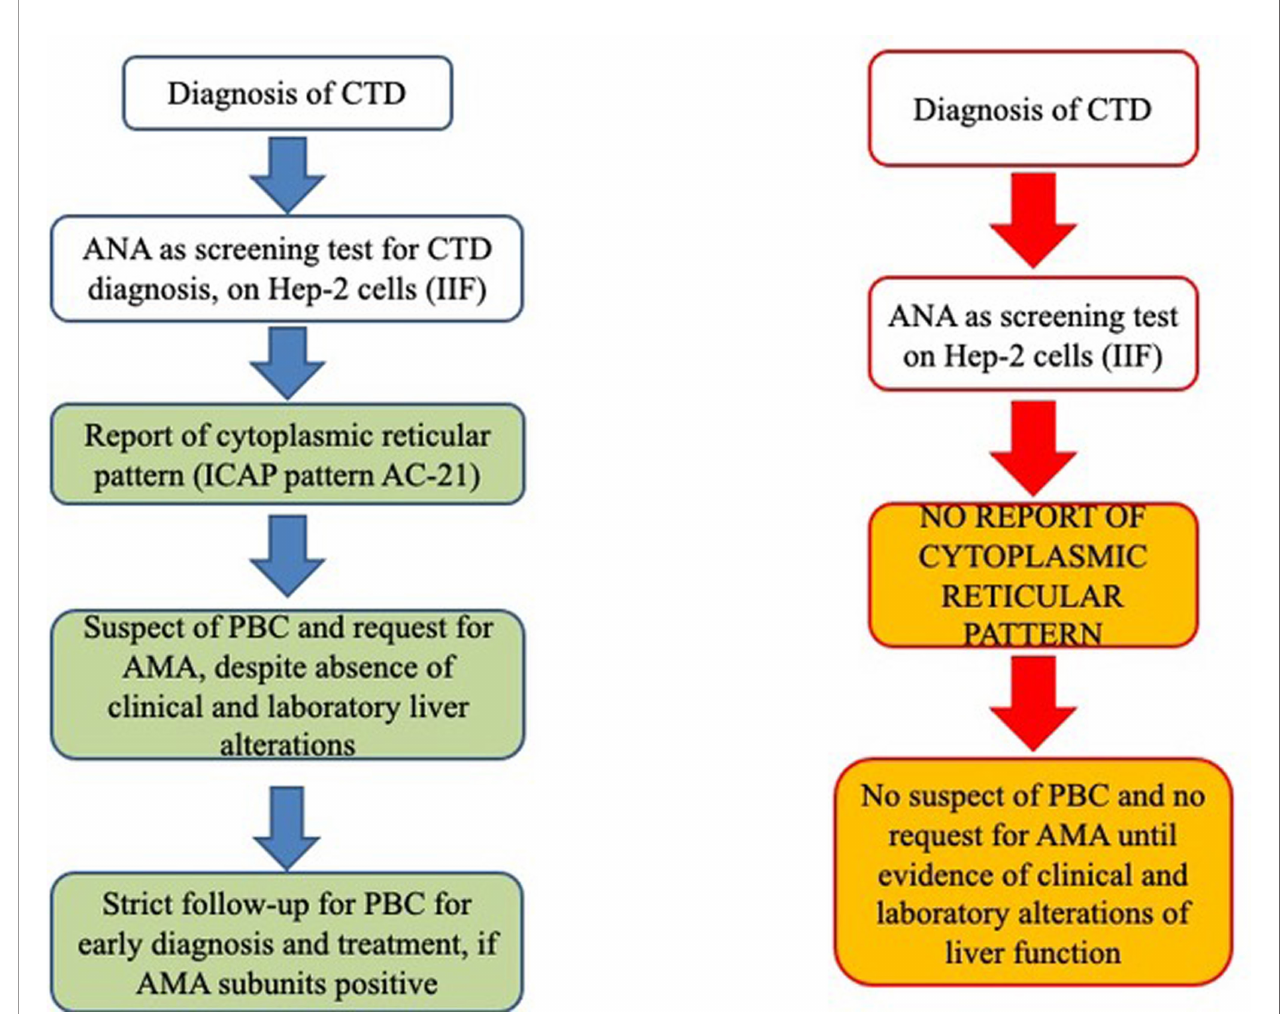
FIGURE 4 | Schematic representation of our proposed working model (left fl ow chart) from the report of cytoplasmic patterns at immuno fl uorescence to additional tests for AMA identi fi cation, before the onset of clinical features suggestive of altered liver function (right fl ow chart). AMA, antimitochondrial antibodies; ANA, antinuclear antibodies; CTD, connective tissue disease; ICAP, International Consensus on Antinuclear Antibody Patterns; IIF, indirect immuno fl uorescence; PBC, primary biliary